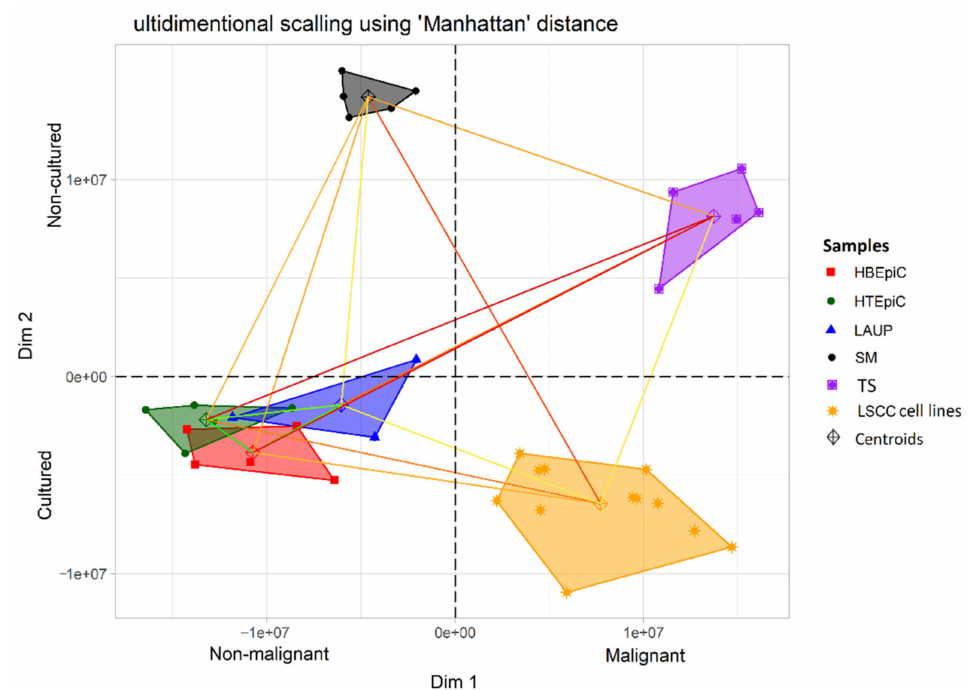
Figure 1. Visualization of MDS analysis using “Manhattan” method, five analyzed cohorts are shown: human bronchial epithelial cells (HBEpiC), human tracheal epithelial cells (HTEpiC), laser assisted uvulopalatoplasty (LAUP), tumor free surgical margins (SM), tumor samples (TS), and LSCC cell lines (LSCC cell lines) from two microarray experiments. The color of the lines represents the relative distance between